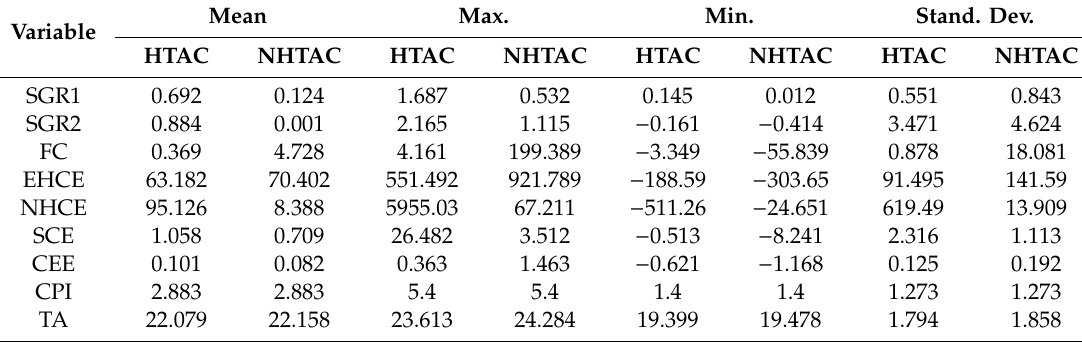
Table 1. Descriptive statistics of variables.